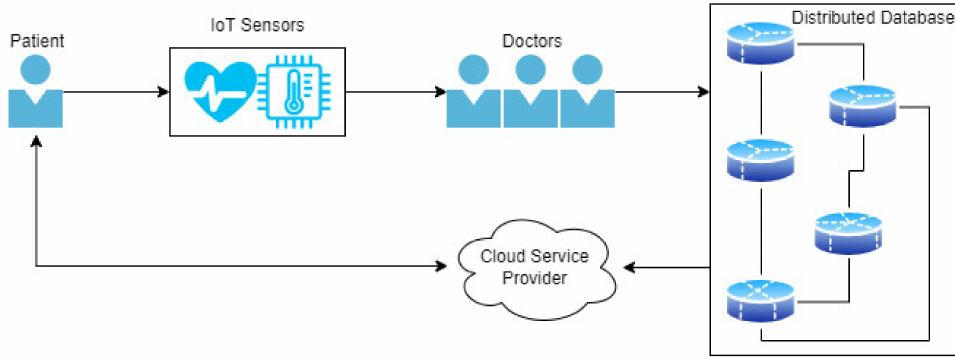
Figure 8. The process of securing patients’ treatments in blockchain healthcare